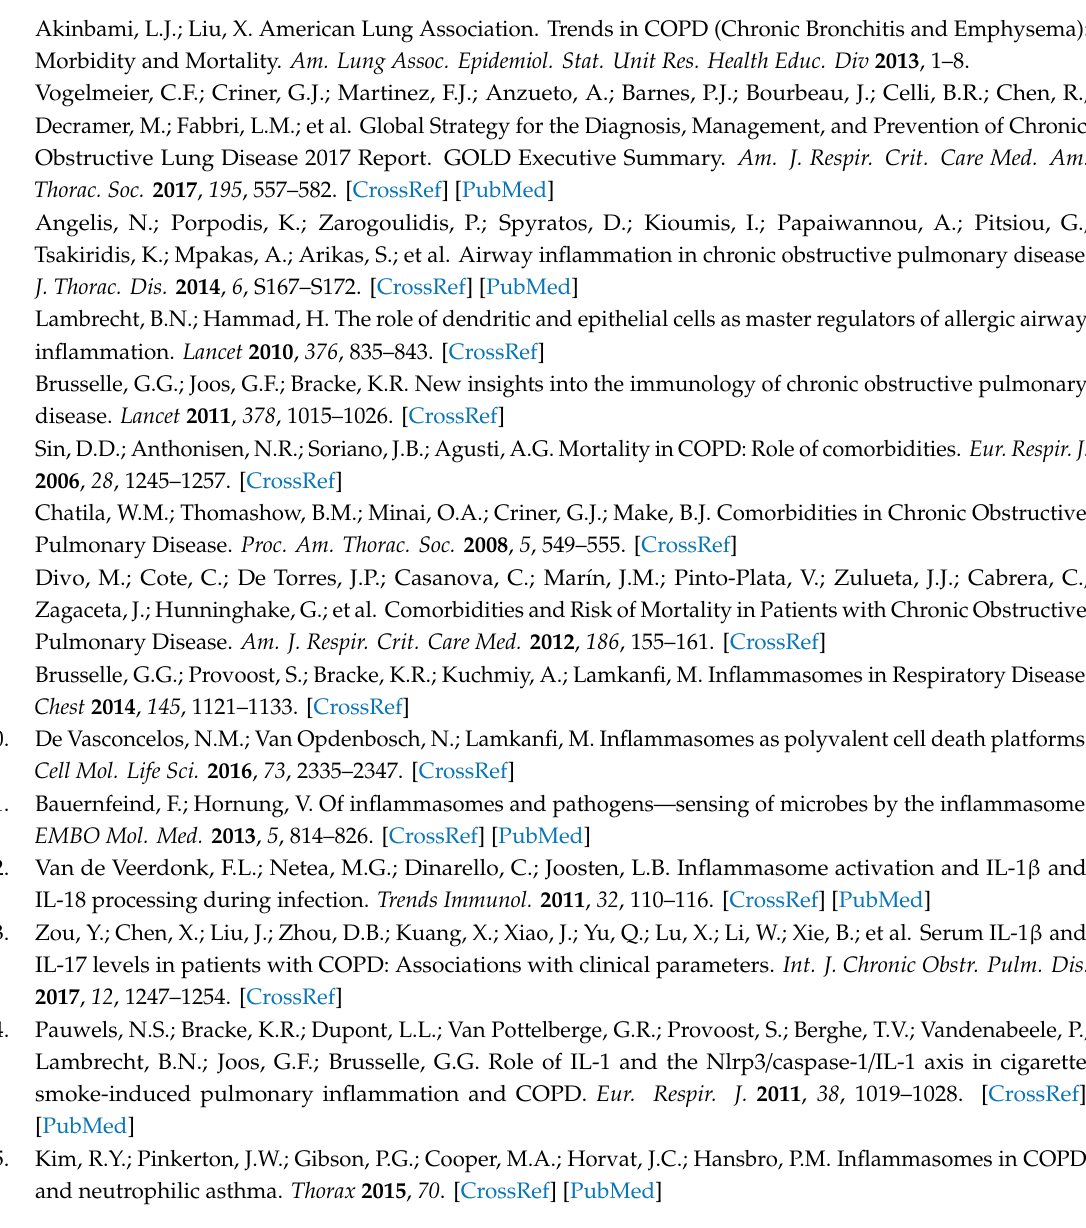
Table S1: Distribution of the NLRP polymorphisms between di ff erent GOLD groups (ABCD). Figure S1: Association of genotypes of NLRP polymorphisms with patients’ overall survival estimated by the Kaplan–Meier